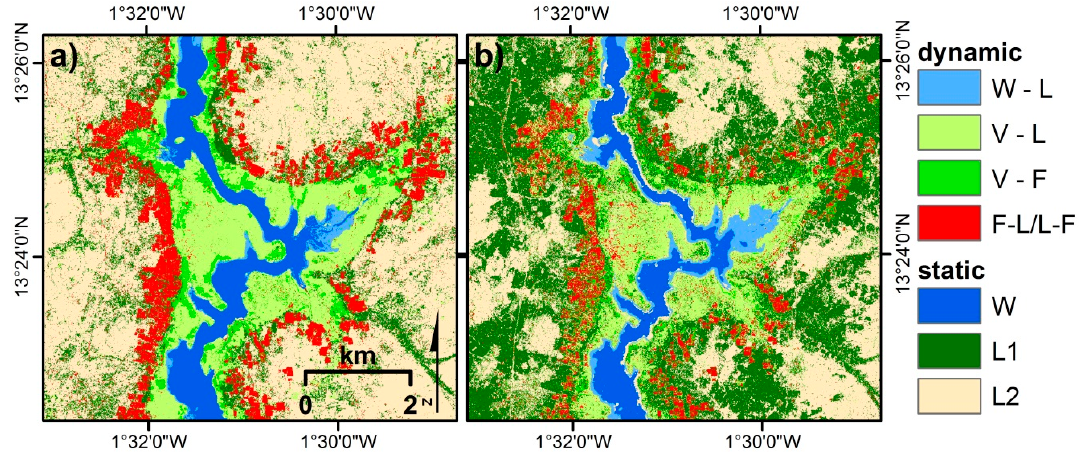
Figure 13. Multitemporal classification results using as input ( a ) dual-polarimetric SAR intensity and phase data vs. ( b ) single-polarimetric SAR intensity (K 0 ) only to classify the following change classes: open water—stable (dark blue); water to land (light blue); flooded vegetation to land (light green); flooded vegetation to field (green); irrigated fields (red); land with permanent vegetation—stable (dark green); and land with soil, rock, urban (beige). Table 8. Accuracy assessment of the multitemporal classification using a stack of all time steps of all four Kennaugh elements (left), compared to using only K 0